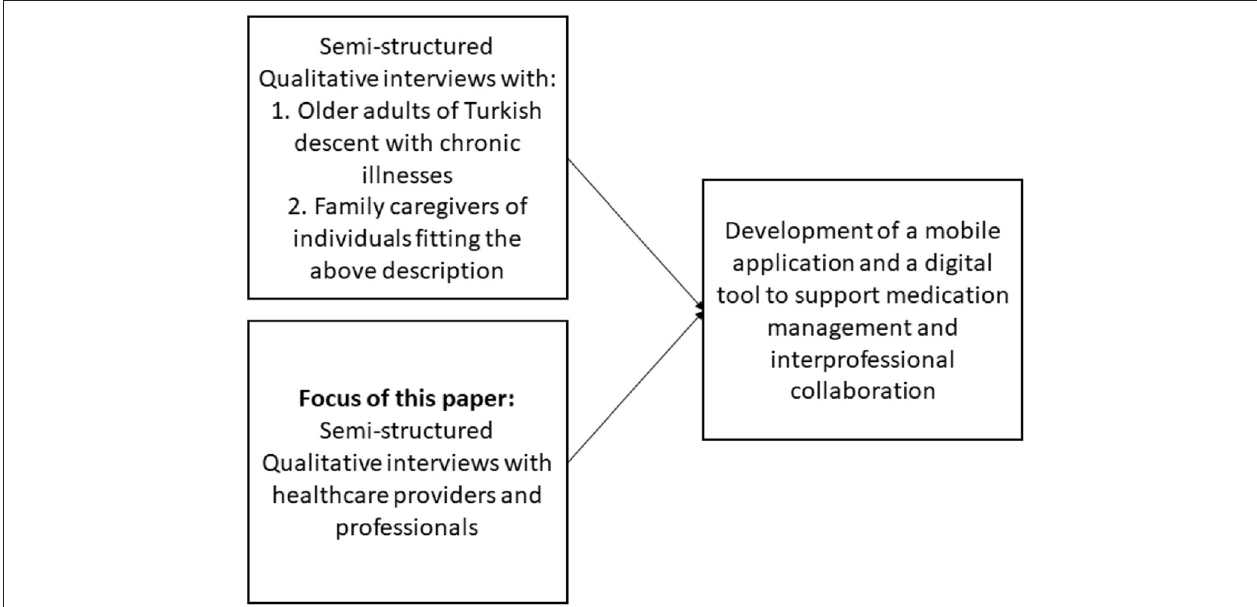
FIGURE 2 | Overview of the three components of the project MedikaMig.